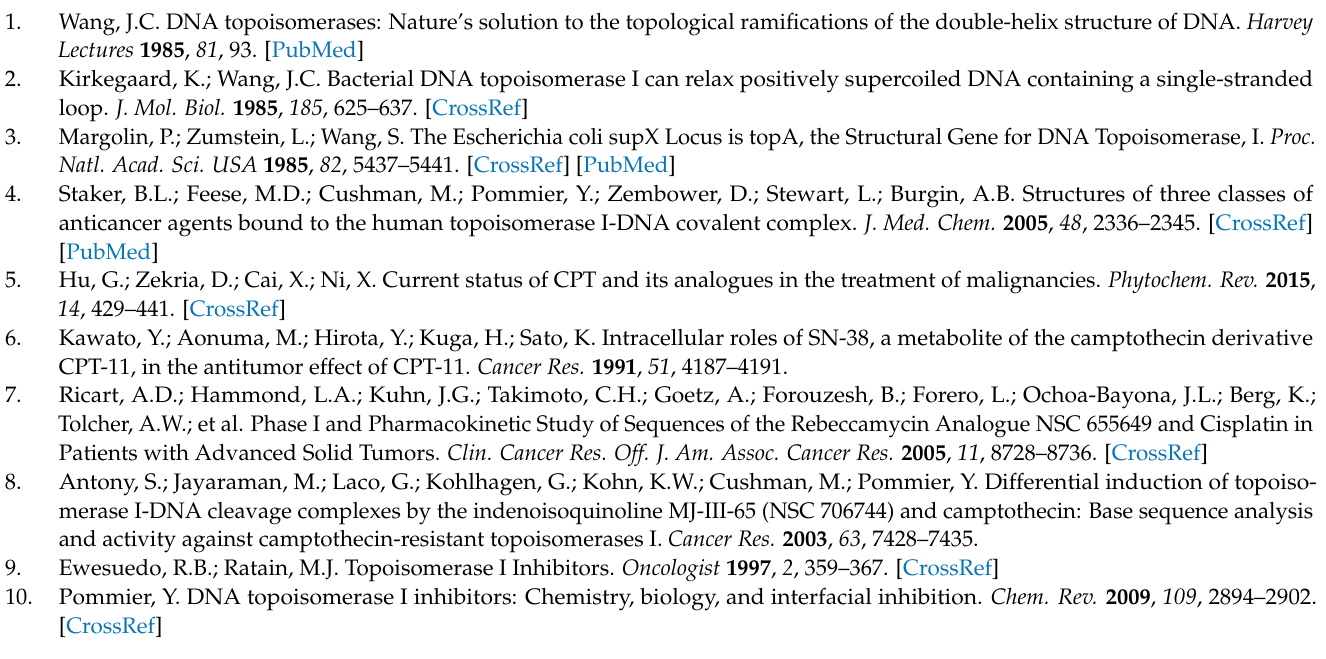
Table S3. The mRNA expression on Tdp1-over CL187, siRNA-Top1 CL187 and siRNA-Tdp1 CL187 cell